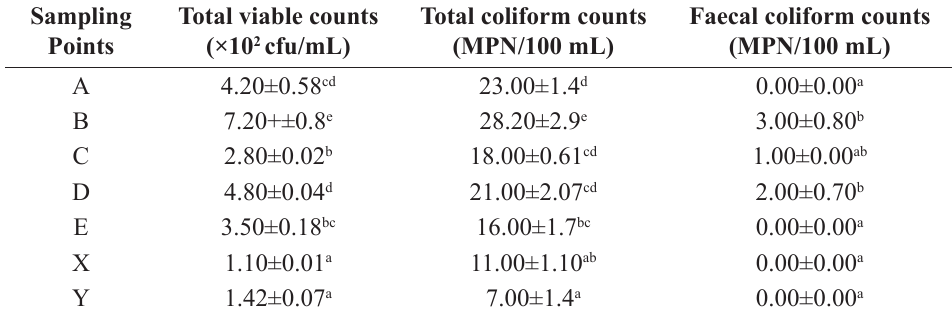
Table 2: Bacteriological counts of the water samples Sampling Points